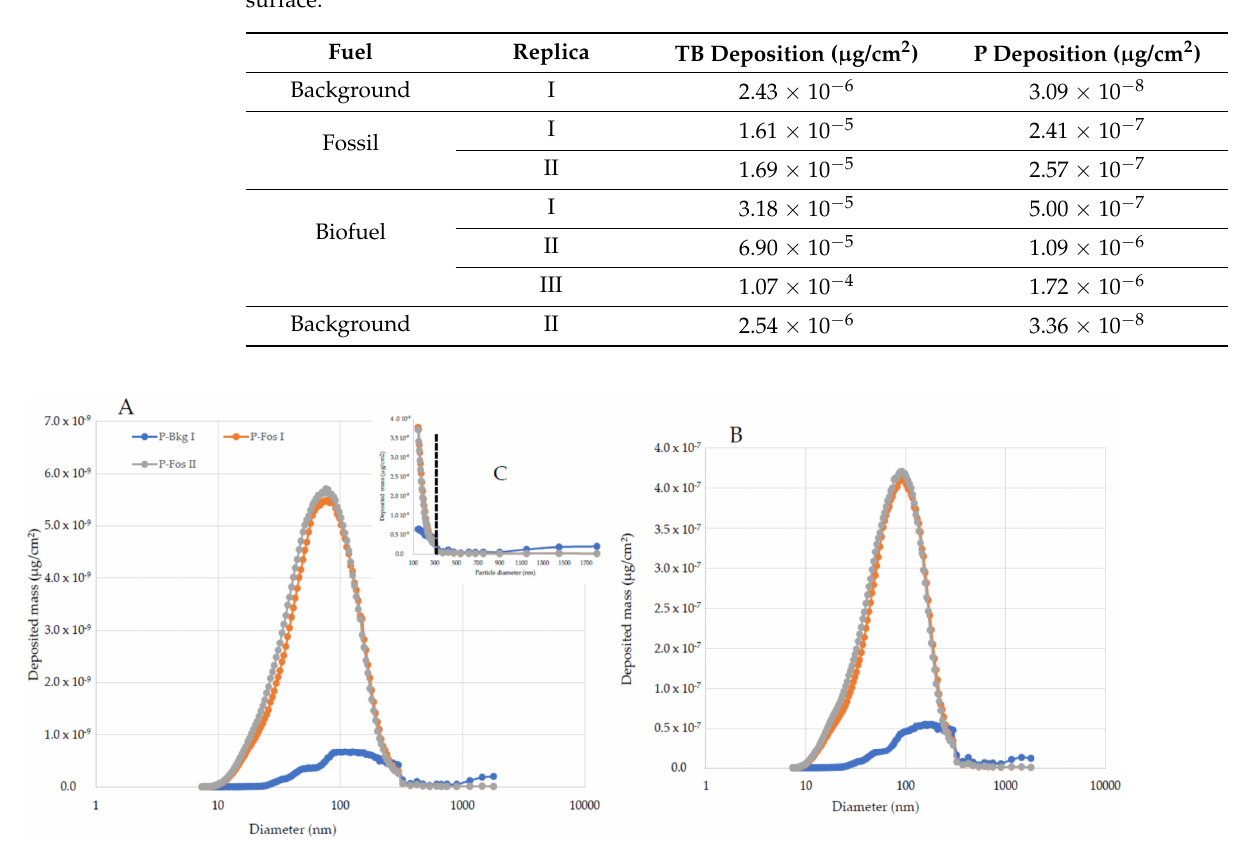
Table 9. Deposited doses of particles during emission tests and during background monitoring.